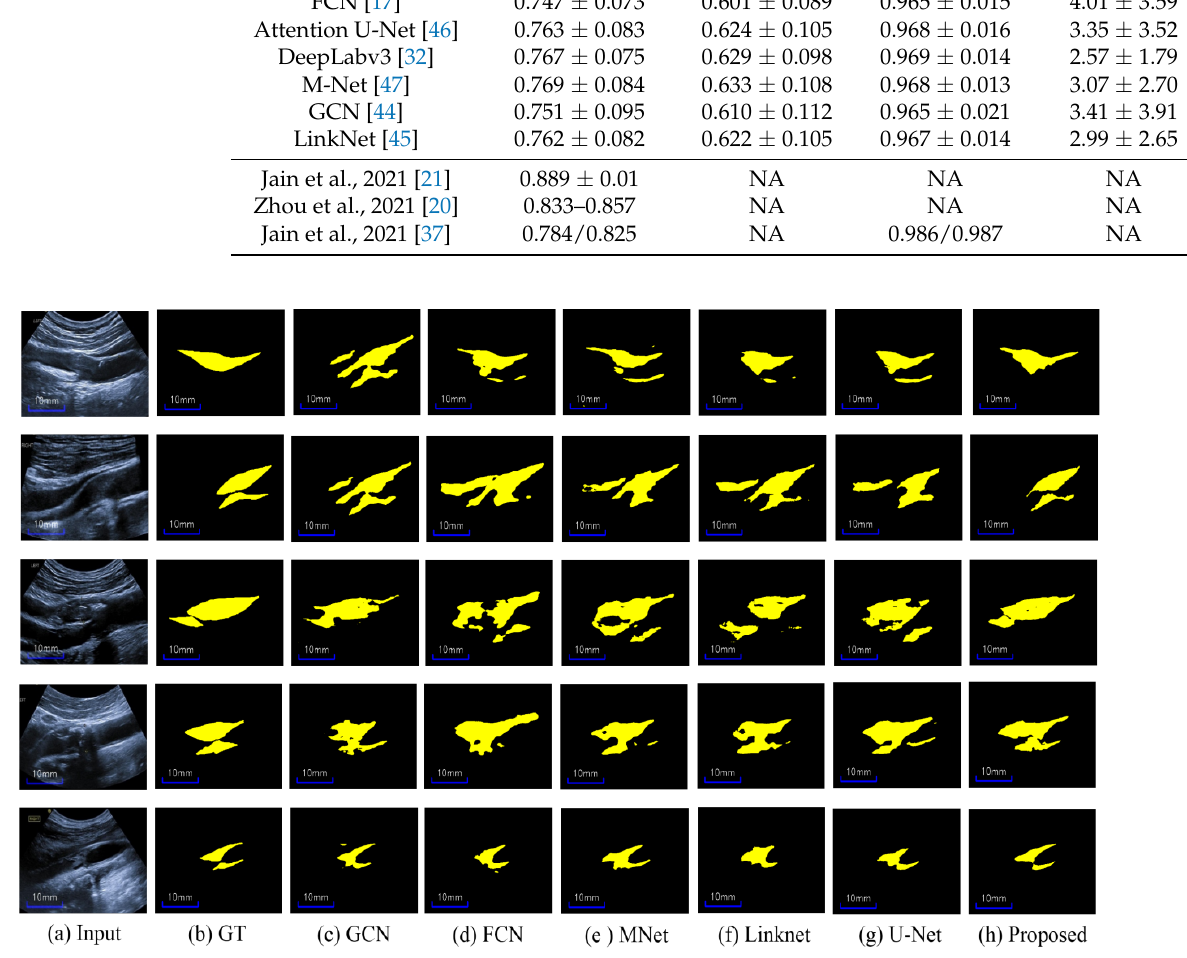
Figure 7. Results obtained by using different methods: ( a ) input images, ( b ) labels, ( c ) GCN, ( d ) FCN, ( e ) MNet, ( f ) Linknet, ( g ) U-Net, and ( h ) proposed method.